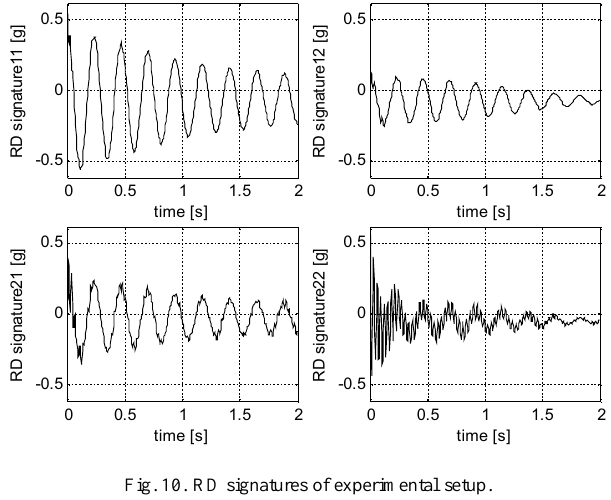
Fig. 10. RD signatures of experimental setup.